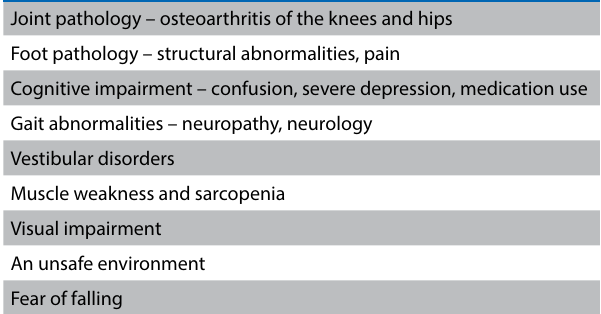
Table 1. Risk factors for immobility and instability